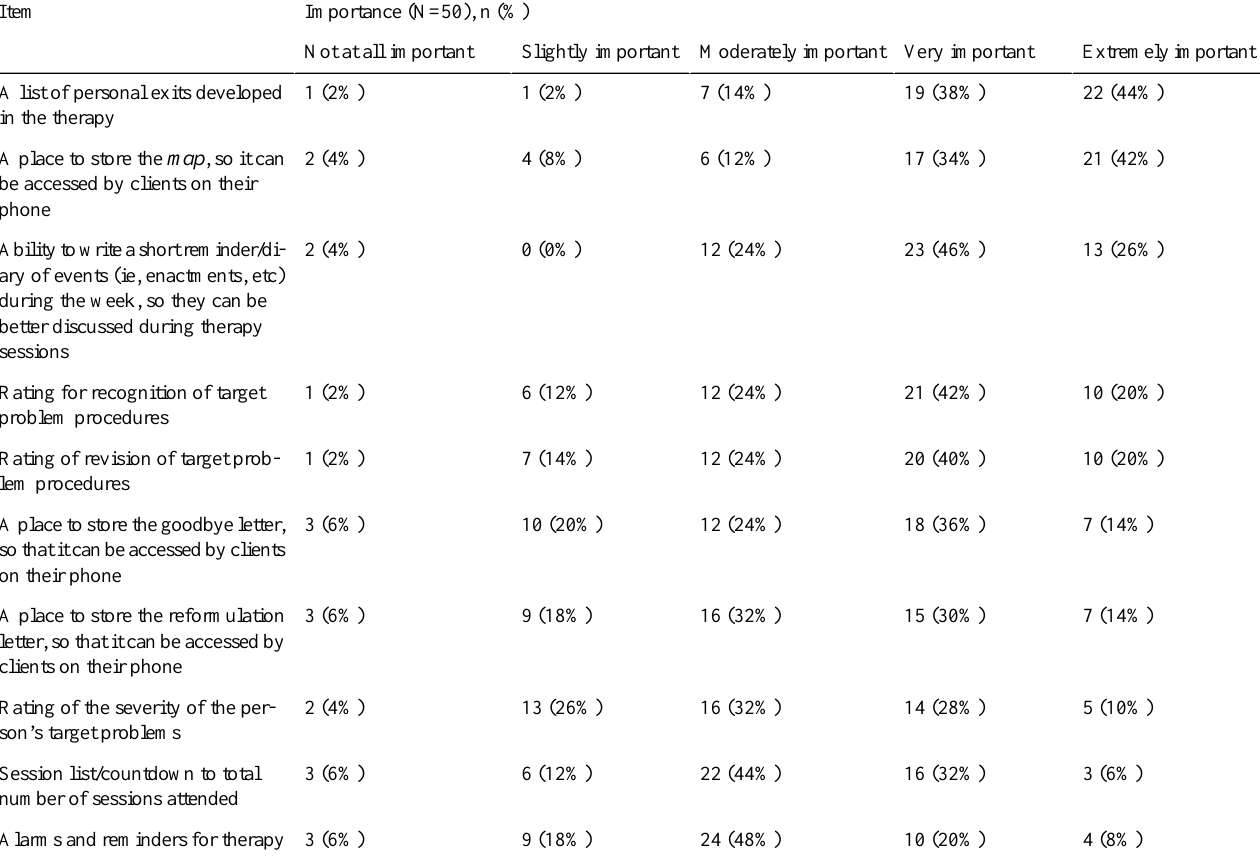
Table 1. Clinical features for inclusion in the app. Importance (N=50), n